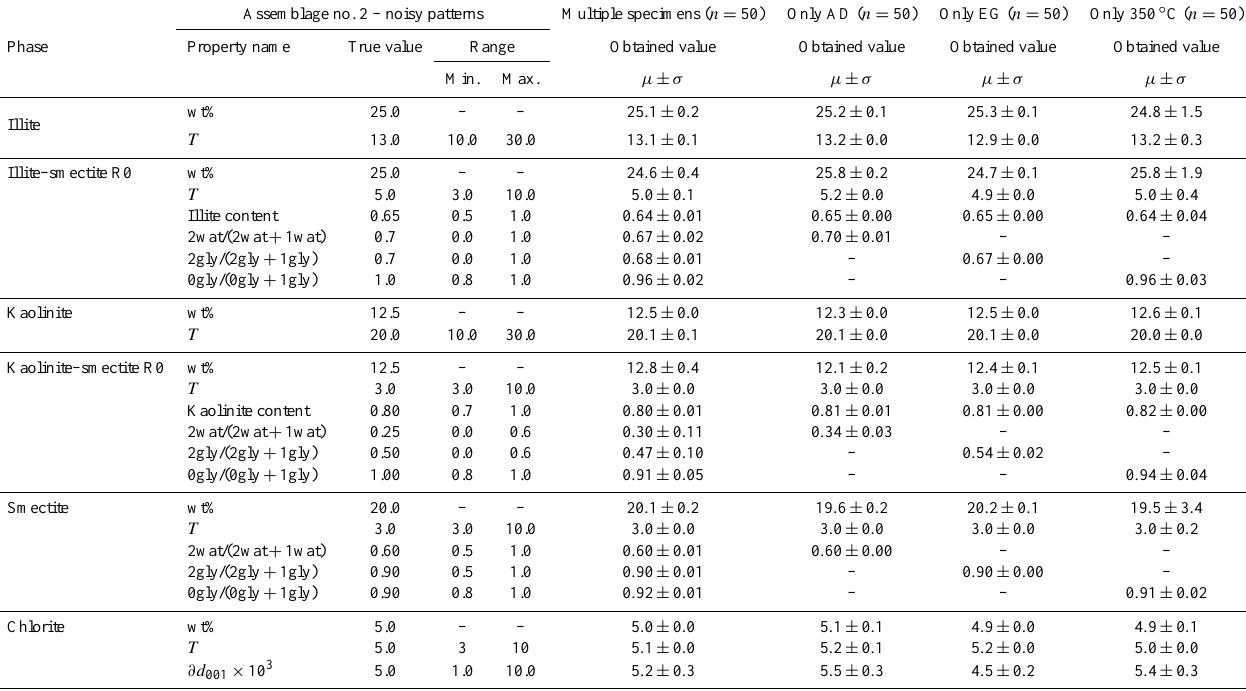
Table 8. Overview of the means and standard deviations of weight fractions and refined parameters for assemblage 2 using noisy patterns. Assemblage no. 2 – noisy